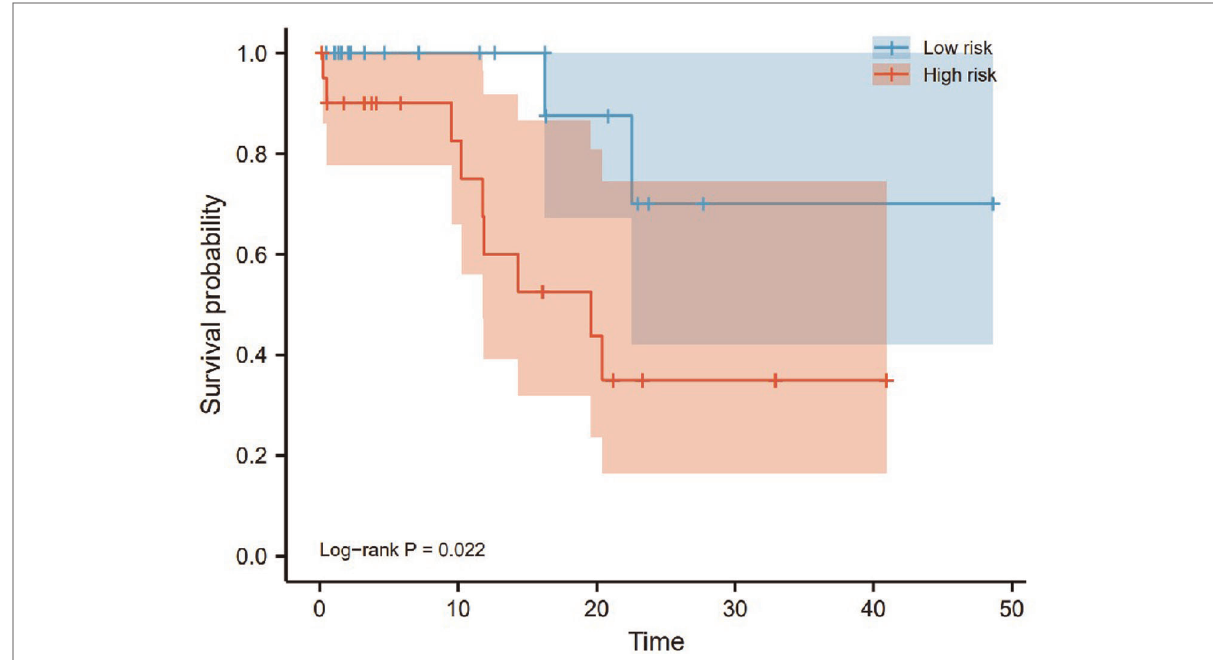
FIGURE 15 Kaplan-Meier analysis of overall survival plots based on RT-qPCR analysis of 41 OSCC patients. The overall survival of the high-risk group was signi fi cantly lower than that of the low-risk group ( P